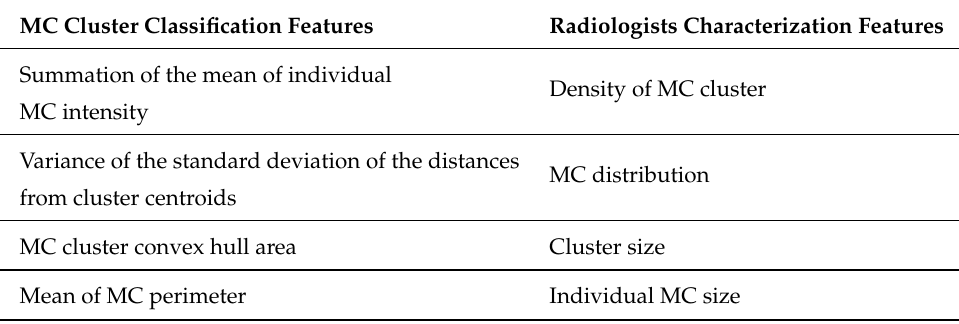
Table 1. Clinical description of the selected features using the DDSM database for classification of MC clusters.